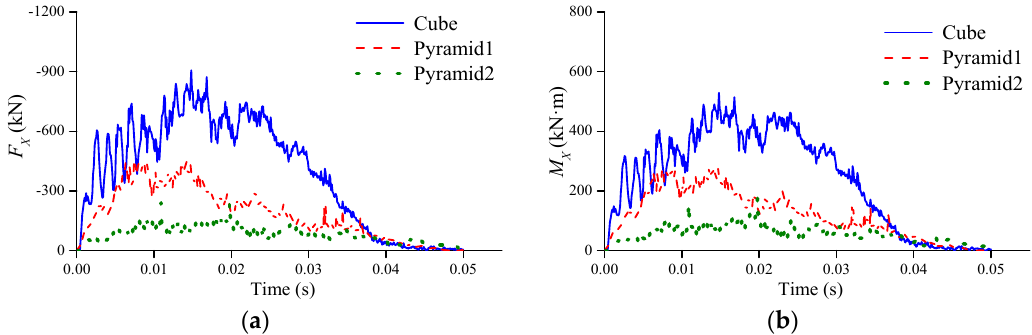
Figure 27. The models of three blocks with different shapes.